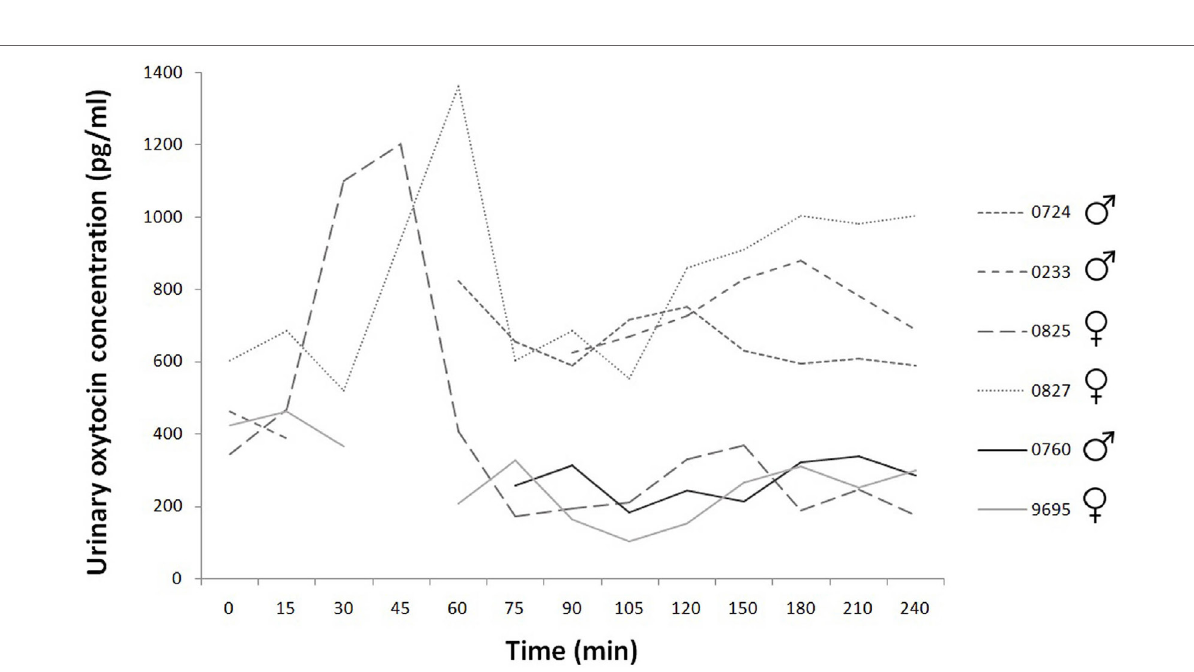
The C/C ratio indicated the normal water metabolism, so the measured oxytocin and cortisol concentrations were not influenced by any of the factors related to the water excretion ( Figure 4